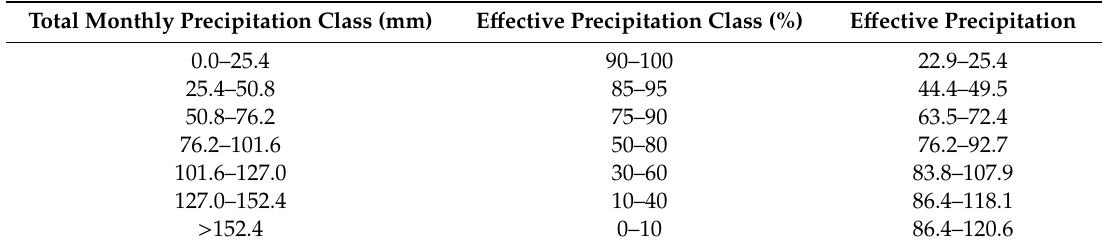
Table 2. Estimating the e ff ective precipitation based on the total monthly precipitation classes (U.S. Bureau of Reclamation